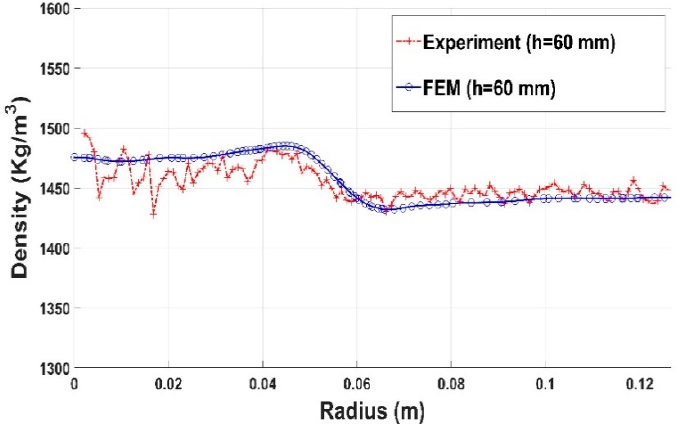
Materials 2019 , 12 , x FOR PEER REVIEW Figure 27. Density profile along the radius (stub hole): experiment vs. finite element result (h = 60 Figure 28. Density profile along the radius (stub hole): experiment vs. finite element result (h = 60 mm). mm). Figure 27. Density profile along the radius (stub hole): experiment vs. finite element result (h = 60 mm).